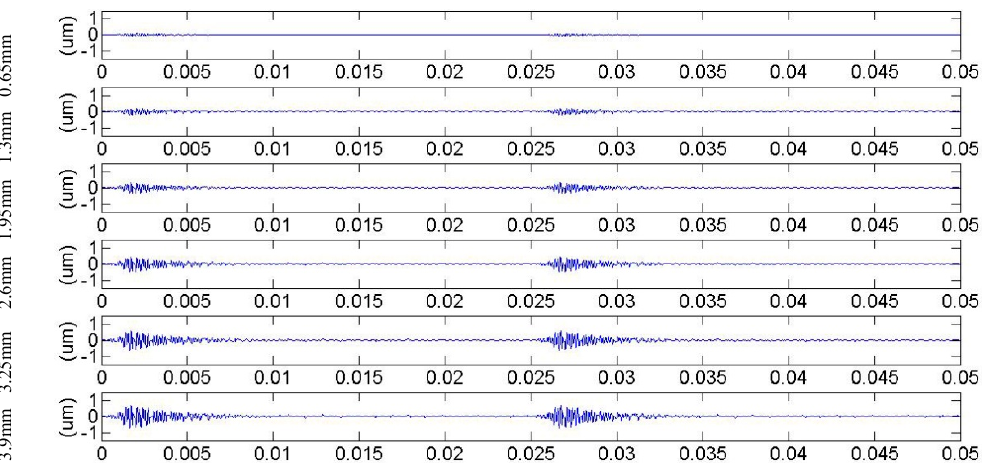
Figure 21. Vibration response for the cracked gear under the 4 mm modulus.